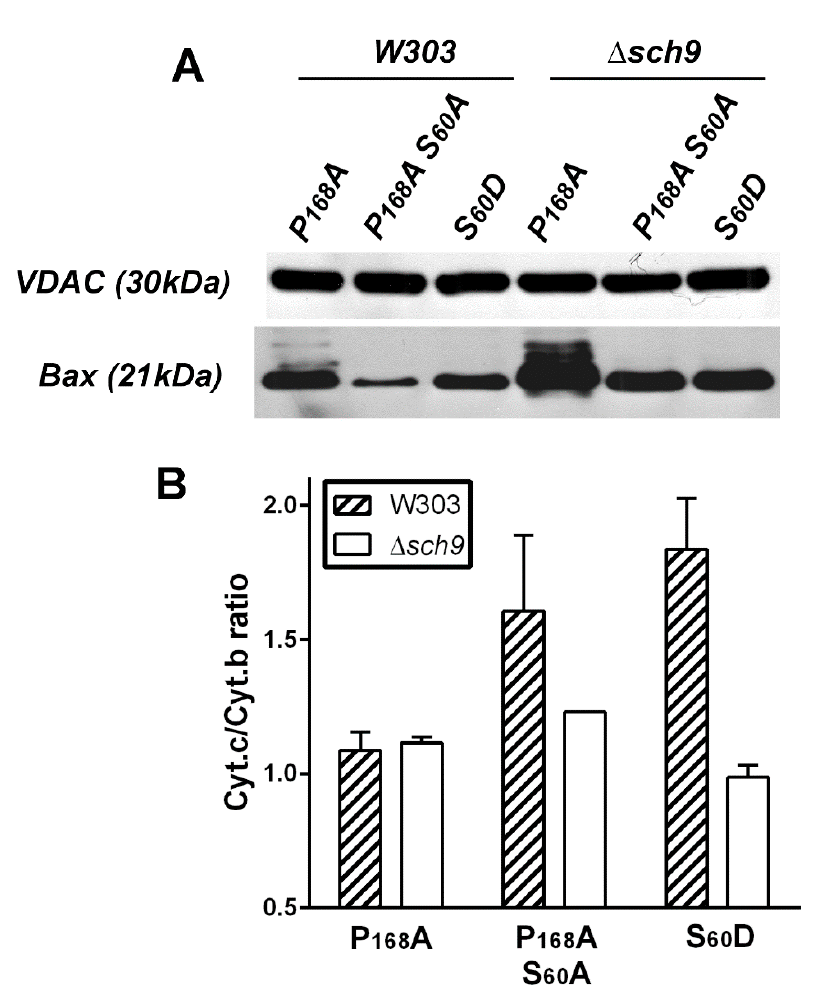
Figure 2. Stimulation of BAX mitochondrial localization and activation in Sch9-deleted yeast. Different BAX mutants were expressed in the wild-type strain W303 or in a mutant carrying a deletion of the gene of the AKT-ortholog Sch9. BAX content was measured in isolated mitochondria with OMM protein VDAC (Voltage Dependent Anion Channel) as a loading control. As previously reported, the cellular content of the three mutants is about the same but they exhibit different mitochondrial localization and level of activity (see Figures 1 and 5 in ref. [81]). The mutant P168A has both a high activity and high mitochondrial localization, and the mutants P168A/S60A and S60D have a weak activity with a weak and intermediate mitochondrial localization, respectively [81]. The P168 residue is in the short loop between α 8 and α 9 helices and its substitution was shown to stimulate BAX in mammalian cells [89], yeast cells [90], and in vitro [91] by favoring the movement of the α 9 helix. The S60 residue is part of a consensus sequence KKLS that might be targeted by a Protein Kinase A, and is in the α 2 helix in close proximity to a negatively charged residue D33 located in the α 1 helix (see ref. [81] for details). ( A ) Western-Blots showing the presence of BAX in isolated mitochondria. ( B ) Redox spectrophotometry measurements of Cyt.c and Cyt.b in mitochondria. Mitochondrial cytochromes absorb light differently in their oxidized and reduced states. The maximal difference between chemically reduced (with Sodium Dithionite) and oxidized (with Potassium Ferricyanide) cytochromes is at 550 nm for cytochrome c and 561nm for cytochrome b with isosbestic points at 540 and 575 nm., with ∆ ε (reduced minus oxidized) = 18,000 M − 1 · cm − 1 for both cytochromes, allowing the precise calculation of their remaining concentration in mitochondria. Cytochrome b is part of the inner membrane respiratory Complex III and is not released during OMM permeabilization, thus serving as an internal control. The decrease of the ratio mitochondrial Cyt.c/Cyt.b ratio reflects the capacity of BAX to release Cyt.c